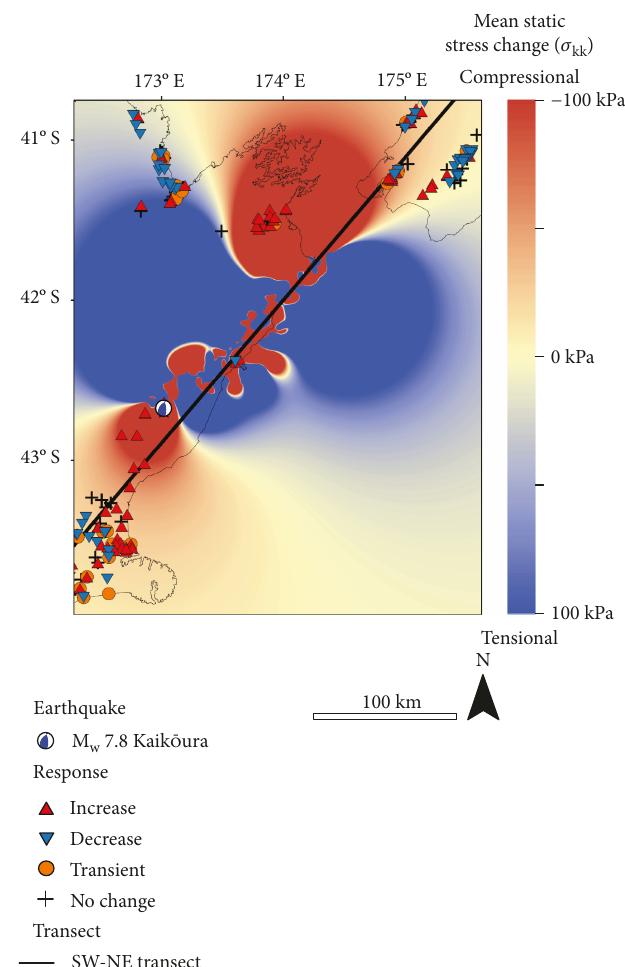
ō ura earthquake. Red colours kk ) induced by the Kaik